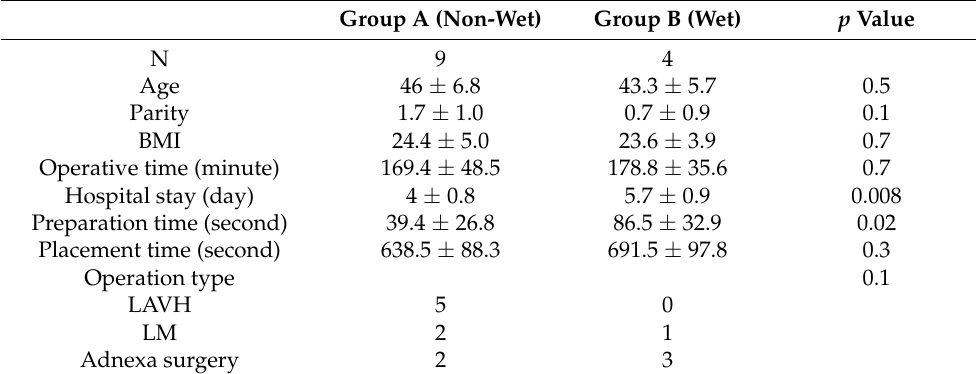
Table 4. Characteristics of failure cases in the two